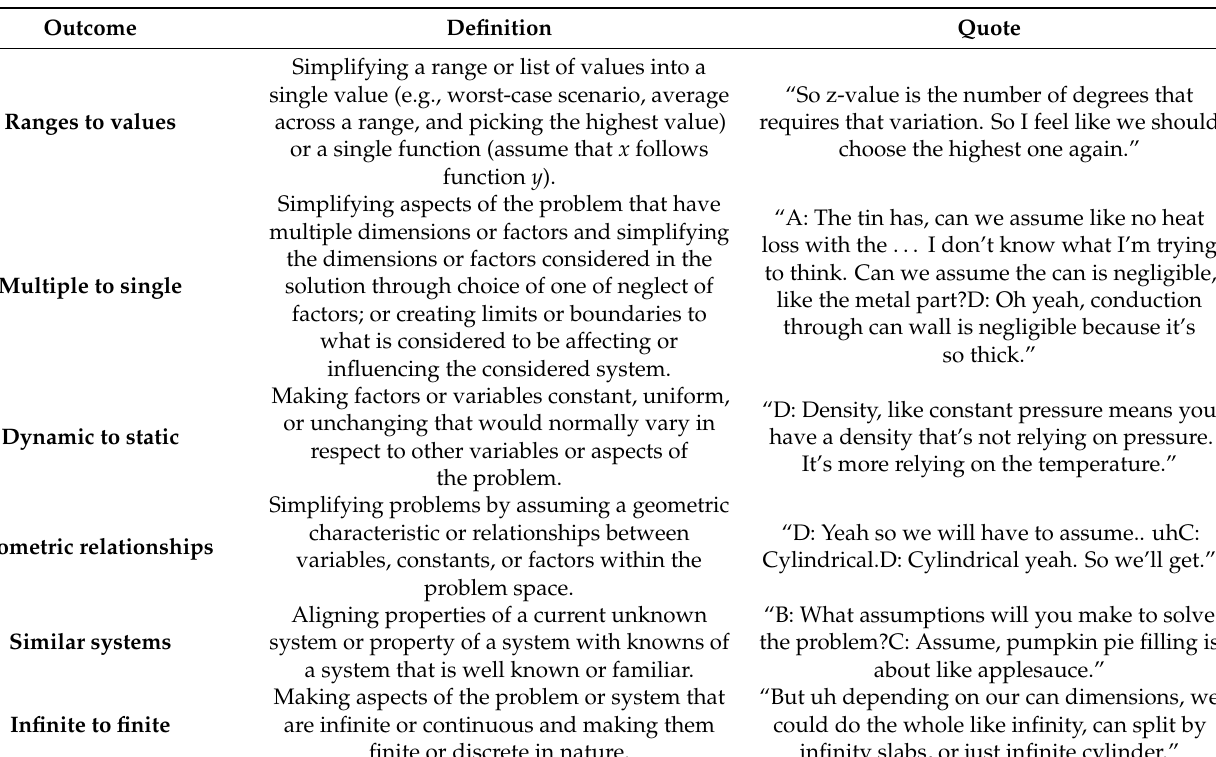
Table 4. Definitions and quotes of CT outcomes identified for abstraction (letters denote individual deidentified